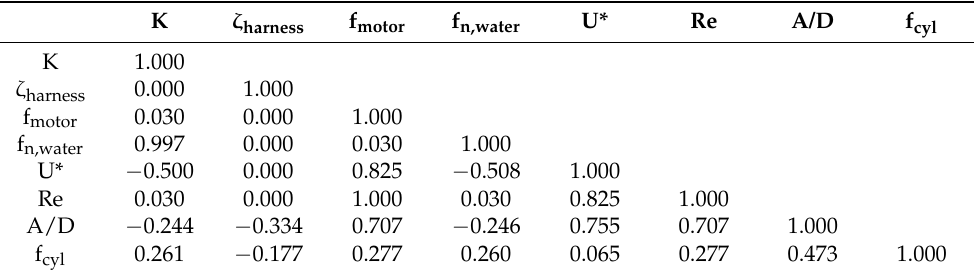
Table 3. Correlation analysis for selecting the independent variables (N =